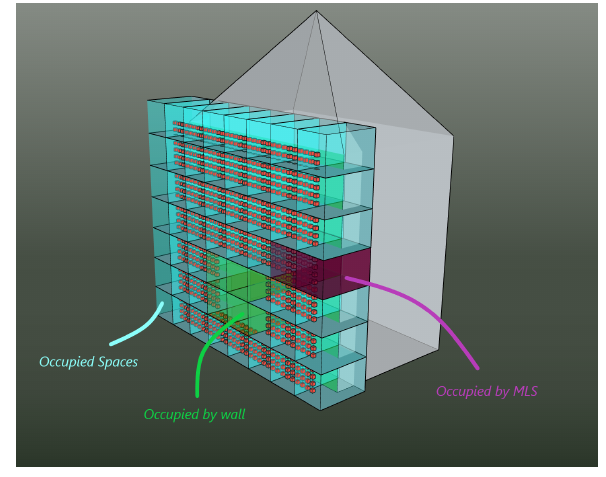
Figure 6. Visualization of voxelized CI space: Confirmed raw geometries with P high (blue), unmodeled elements with P moderate (purple), and P low for other city objects (green).